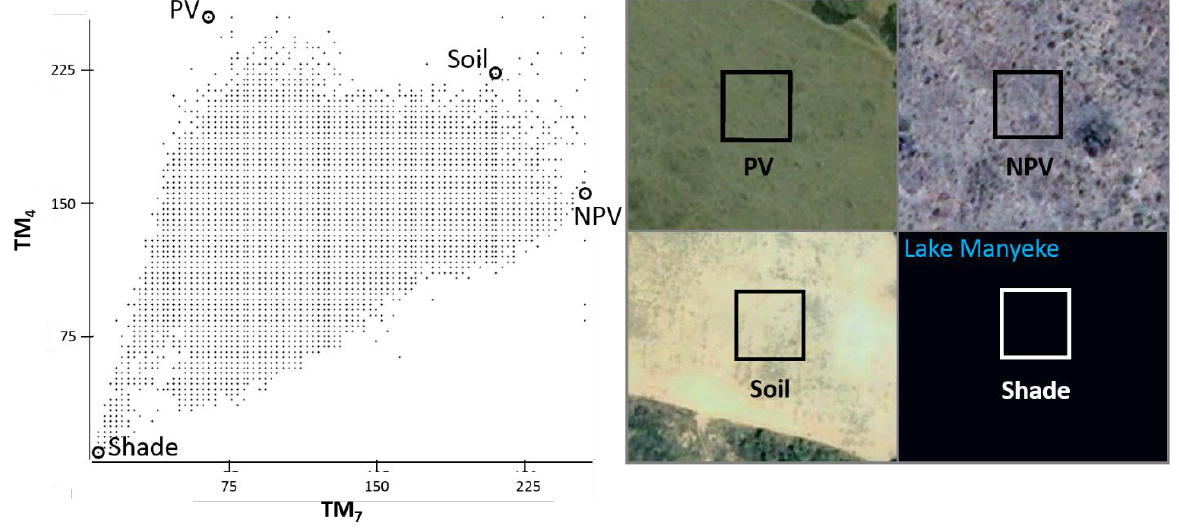
Figure 4. ( Left ): Location of selected endmembers in scatterplot where Landsat TM band 4 is assigned to the y-axis and band 7, the x-axis. Values of X and Y-Axes are at-surface reflectance. ( Right ): Endmember pixel boundaries mapped and overlaid on high-resolution imagery (Google